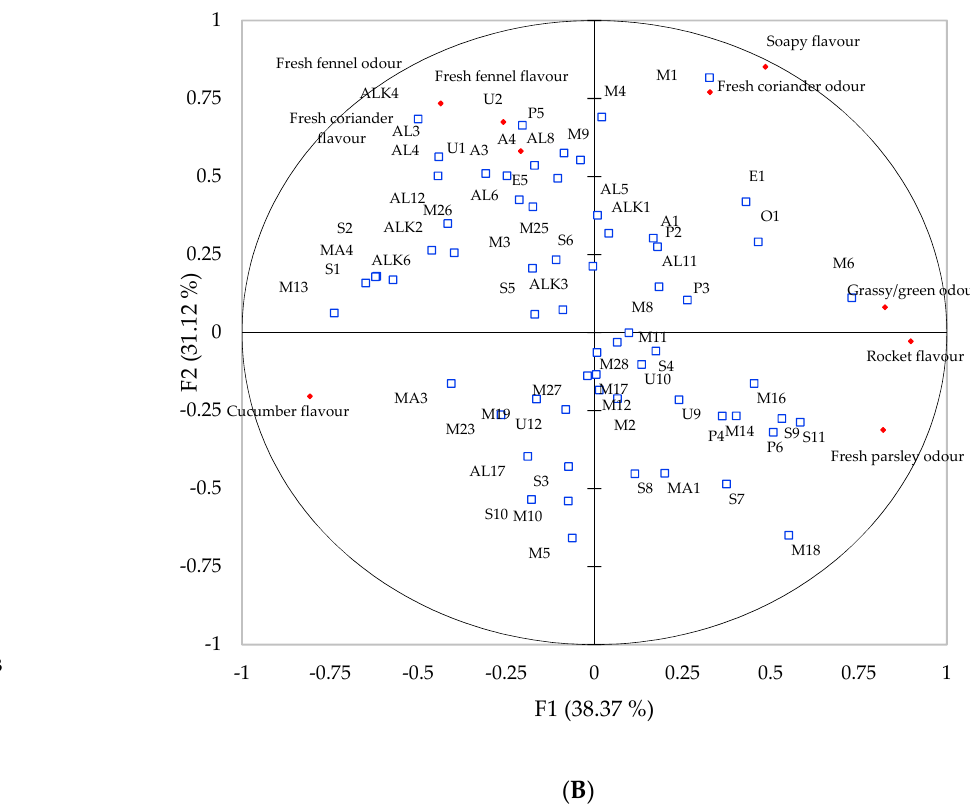
Figure 2. Principal component analysis of eight celery samples harvested in UK 2018 showing correlations with volatile compounds and sensory attributes. ( A ) Projection of the samples; ( B ) Distribution of variables.